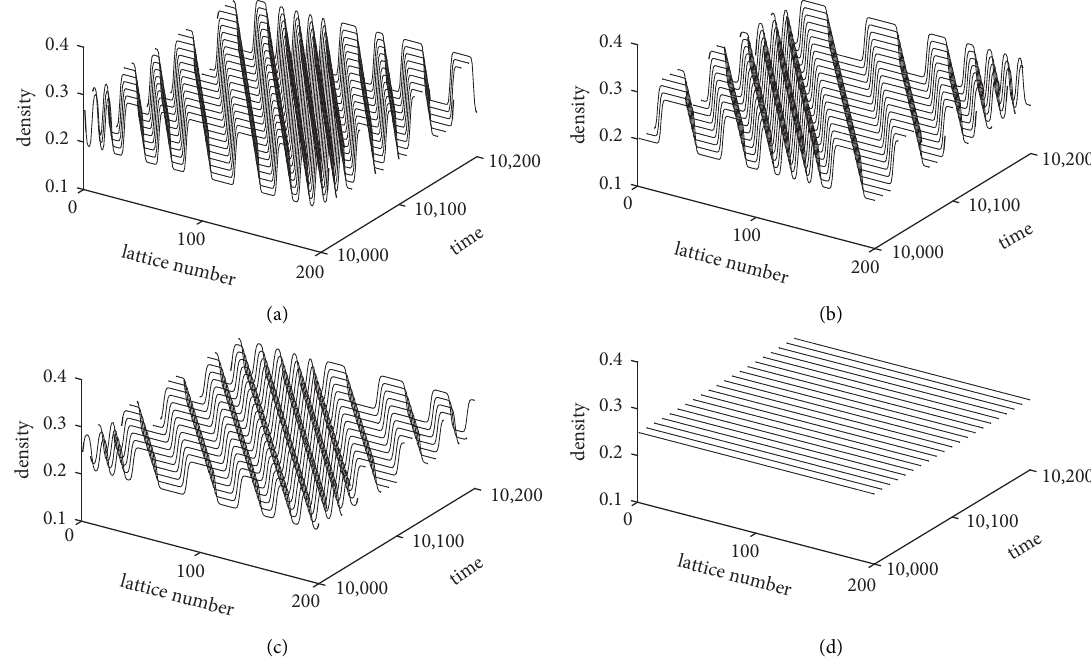
Figure 4: The evolution of the traffic densities for different values of parameter τ : (a) τ � 1 . 0; (b) τ � 1 . 5; (c) τ � 2 . 0; (d) τ � 2 . 5.